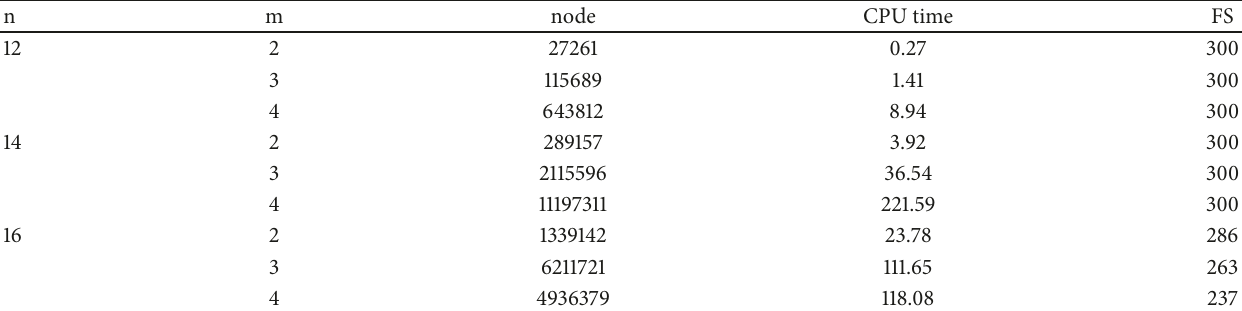
Table 4: The impact of m in the branch-and-bound algorithm.